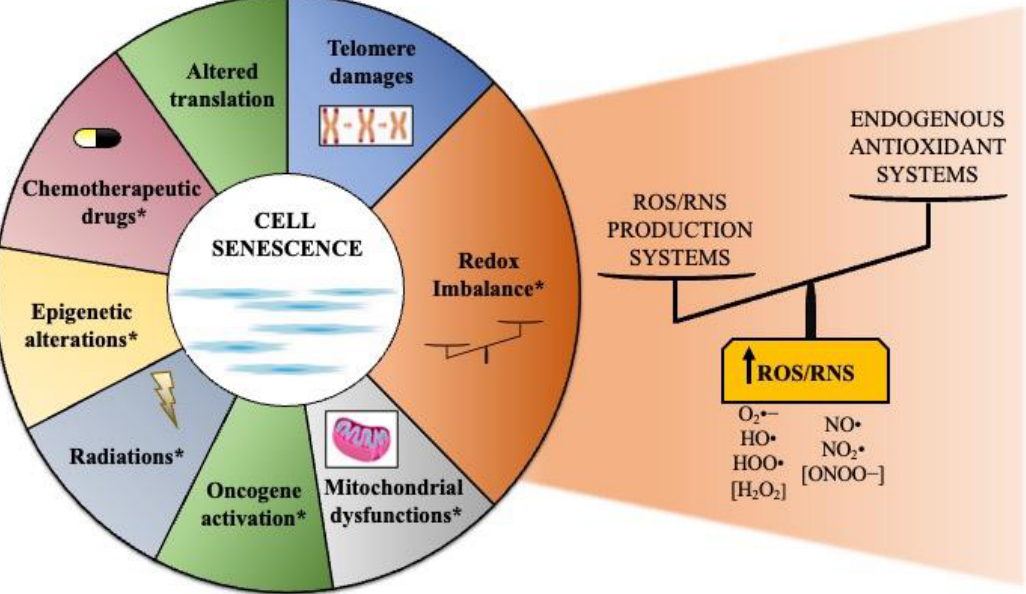
Figure 1. Intrinsic and extrinsic causes of cellular senescence. Schematic diagram showing the major inducers of cellular senescence. Damages to telomeres, redox imbalance, mitochondrial dysfunctions, activation of oncogenes, ionizing/ultraviolet radiations, epigenetic and chromatin alterations, chemotherapeutic drugs, and altered translation can promote the senescence program. Redox imbalance can be generated by decreased endogenous antioxidant defenses or increased ROS/RNS production. The main ROS/RNS are reported (the non-radical species are indicated in parenthesis). Most of these senescence inducers act by releasing ROS/RNS or by increasing ROS/RNS production. ROS/RNS can directly affect telomere integrity and cause altered translation process. * indicates senescence inducers that release or increase ROS/RNS.